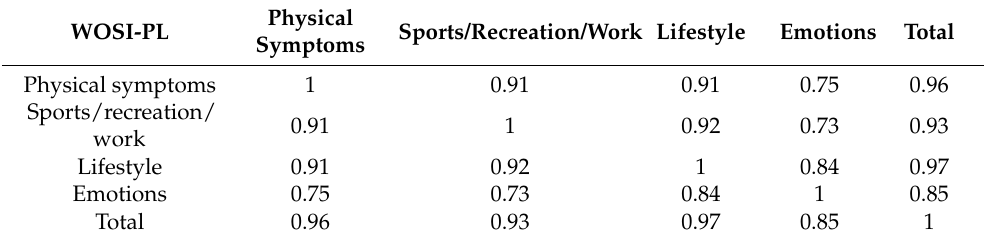
Table 3. Spearman’s correlation coefficients (SCC) between the domains of the WOSI-PL ( n =